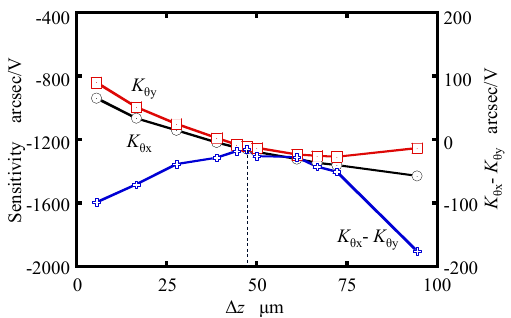
Figure 10. Relationship between ∆ z and the detector sensitivity.